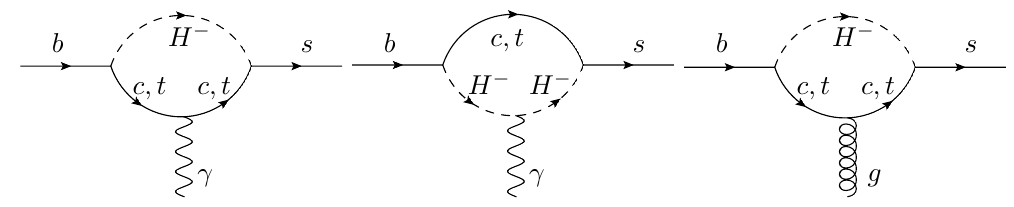
and C ( 0 ) given in eq. (3.10), 7 8